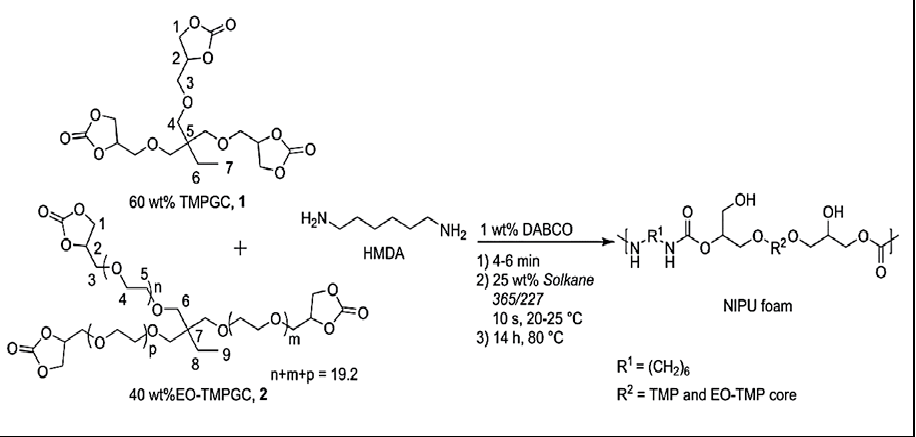
Figure 3. Reaction to obtain NIPUF using Solkane 365/227. Reprinted from ref [43]) with permission from the publisher.